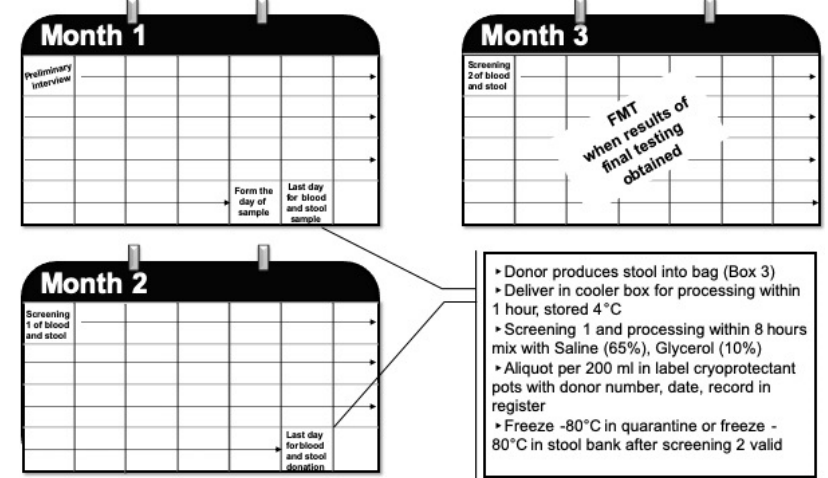
Figure 1. Maximal timing of the various mandatory steps to obtain a bank of ready-to-use FMT samples. The deadlines for carrying out the analyses after the samples can be reduced but are at the maximum of 1 month after the donation.